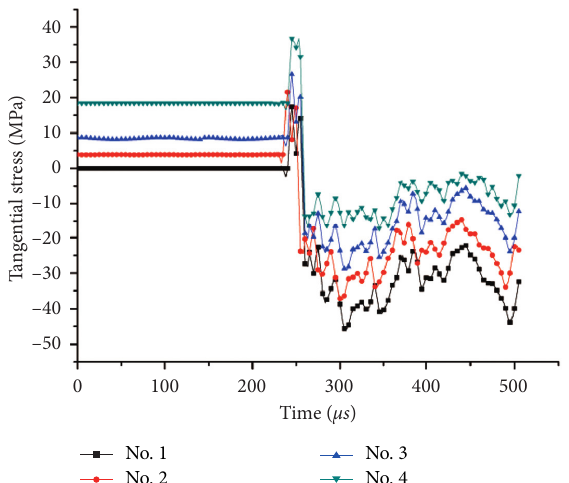
Figure 5: Curves of changes in stress at calculated points under the action of the combined stress field.